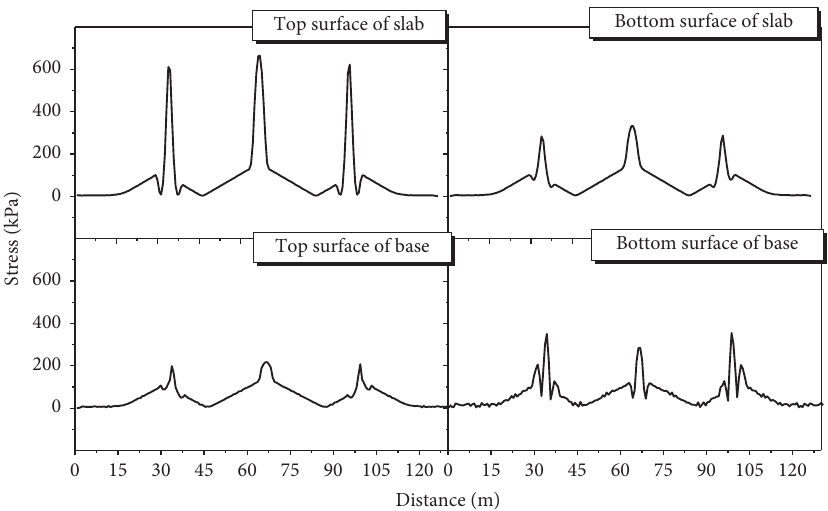
Figure 5: Static stresses on the top and bottom surfaces of the slab and base.